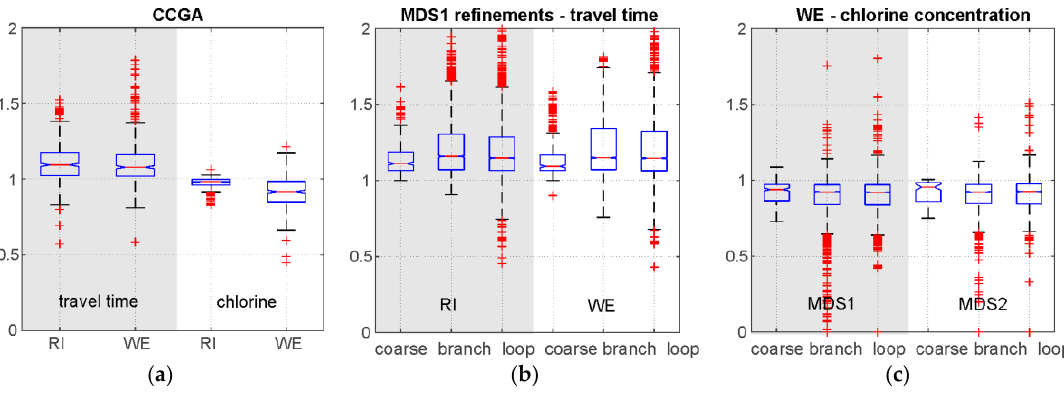
Figure 11. Statistical comparison of the different scenarios ( a ) CCGA model; ( b ) the MDS1 model with different refinement strategies ( c ) structural impact between MDS1 and MDS2.